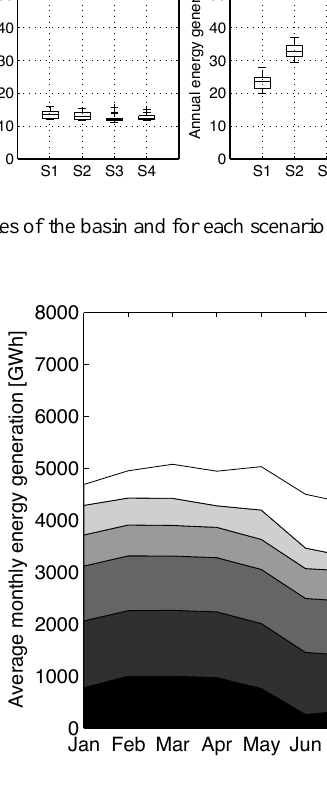
Fig. 10. Stacked monthly average energy generated by the major power plants throughout the basin – scenario 3.